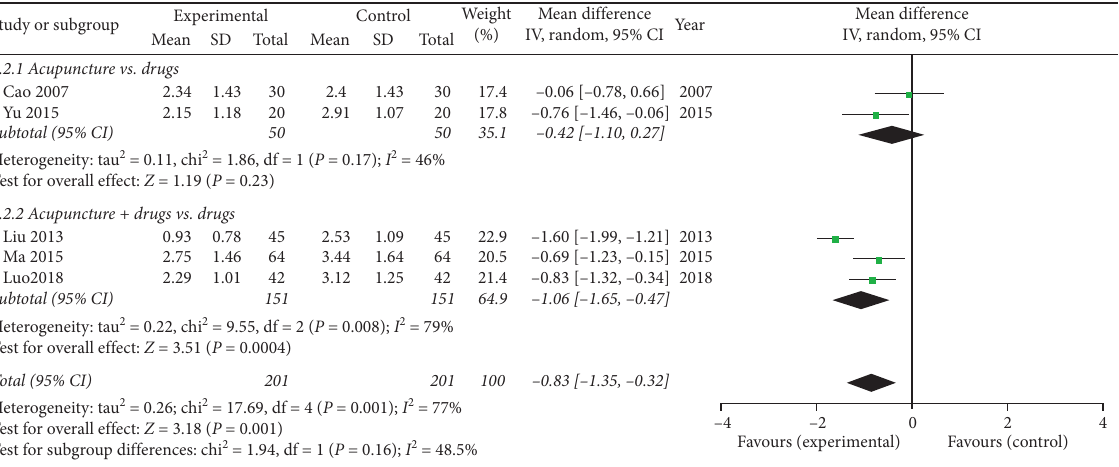
Figure 5: Meta-analysis for the VAS score of acupuncture versus the control group.